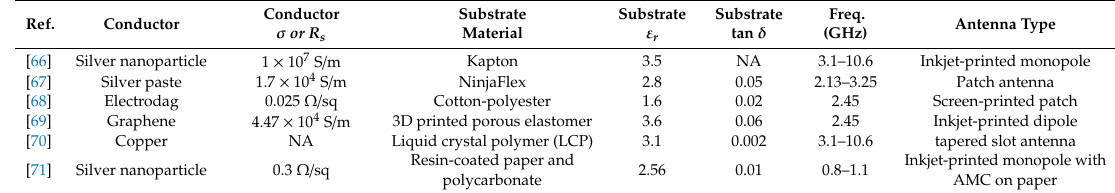
Table 5. Examples for antenna based on printing technique.